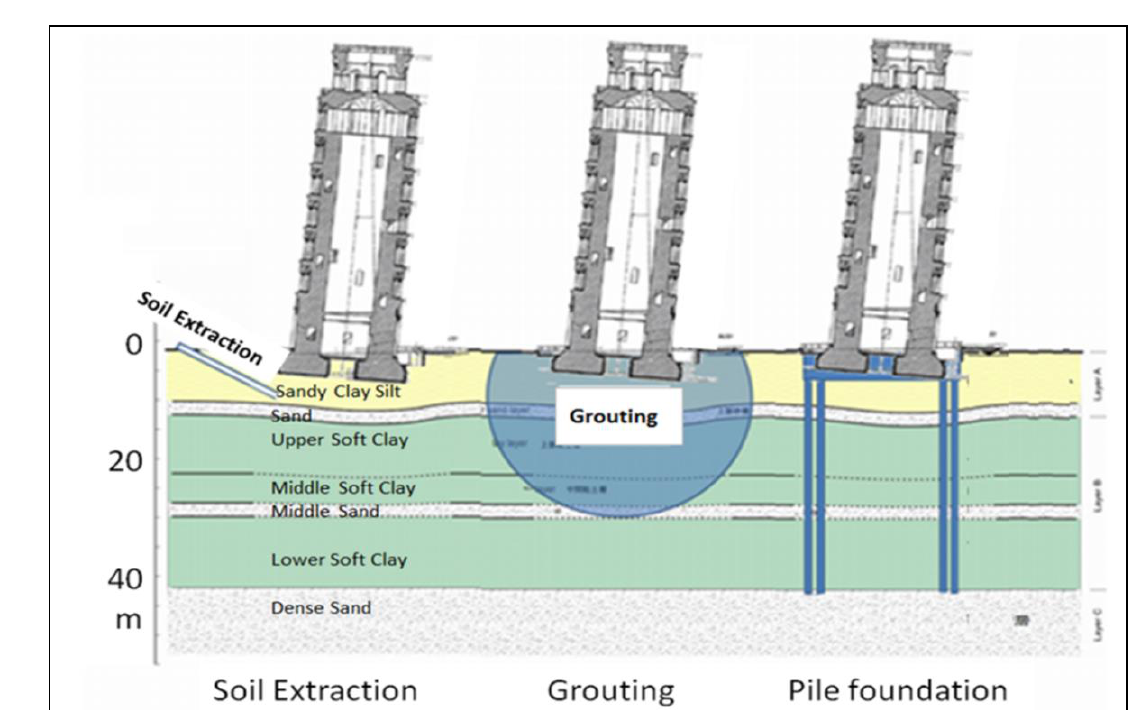
Figure 1. Restoration methods for the leaning Pisa Tower.